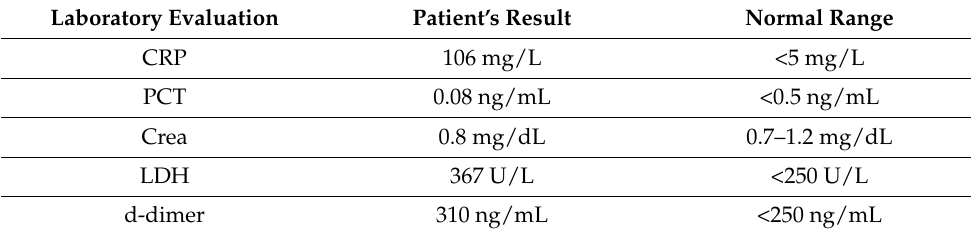
Table 1. Laboratory findings on admission.